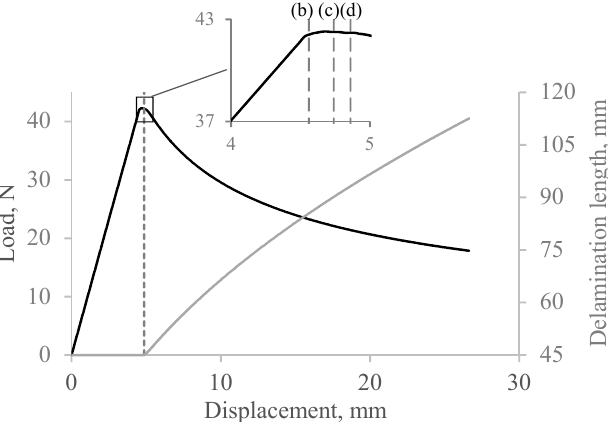
Figure 17. Simulated Mode I load and delamination length versus opening displacement.